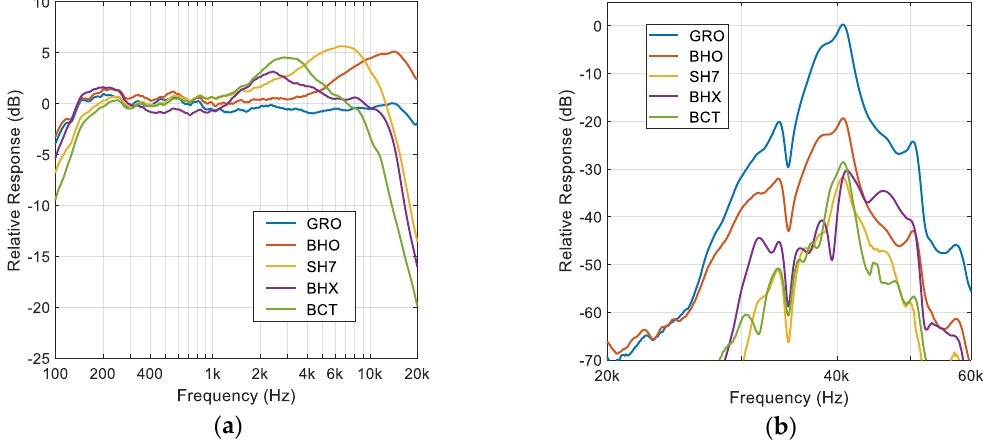
Figure 3. Relative frequency response of the different microphones. ( a ) Response in the audible range with a calibrated monitor as an emitter. ( b ) Response in the ultrasonic range with the ultrasonic array used as the emitter. Response normalized at carrier level measured by a GRO microphone.